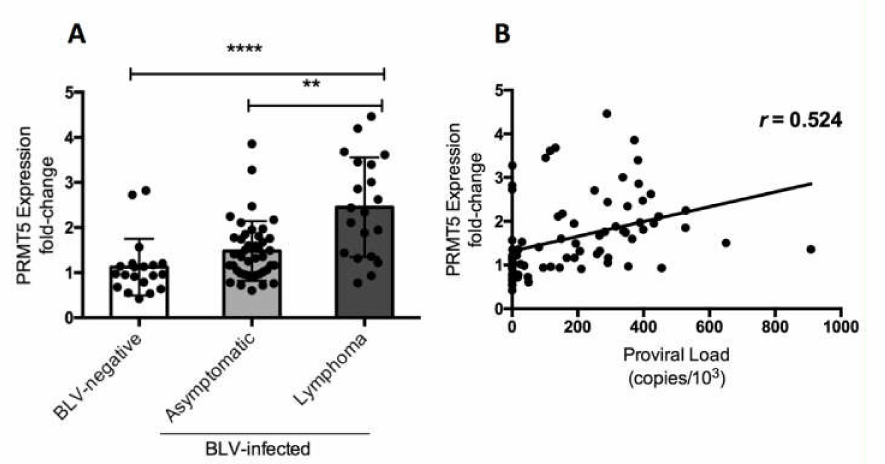
Figure 3. PRMT5 gene expression at the RNA level in BLV-infected cattle with lymphoma. ( A ) PRMT5 expression at the RNA level of 20 BLV-negative cattle, 42 BLV-infected but clinically normal cows, and 20 BLV-infected cattle with lymphoma were measured by qRT-PCR and the fold-change was calculated using the ∆∆ CT method with normalization to GAPDH expression as an internal control. Samples were run in duplicate. A scatter plot with a bar showing the mean of the fold-change in PRMT5 expression of the three groups of cattle. BLV PVL was measured by CoCoMo-qPCR. The p value was calculated using the Kruskal-Wallis test ( < 0.0001) and Dunn’s multiple comparisons test was used to evaluate the significance among groups. The asterisk indicates a significant di ff erence (** p ≤ 0.001